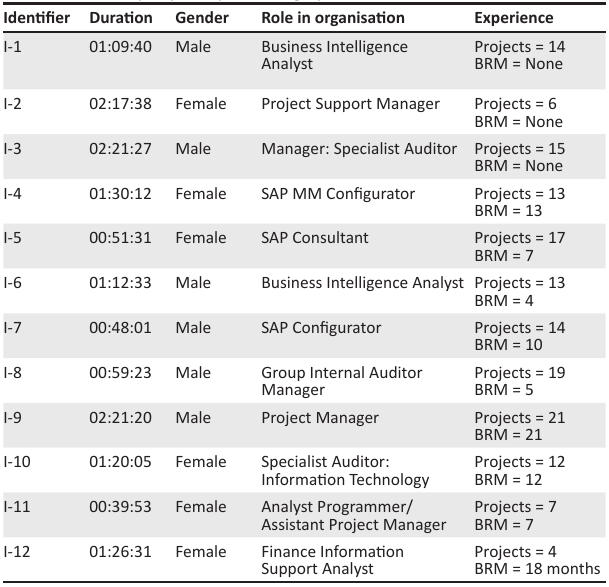
TABLE 3: Summary of participants’ biographical information. Identifier Duration Gender Role in